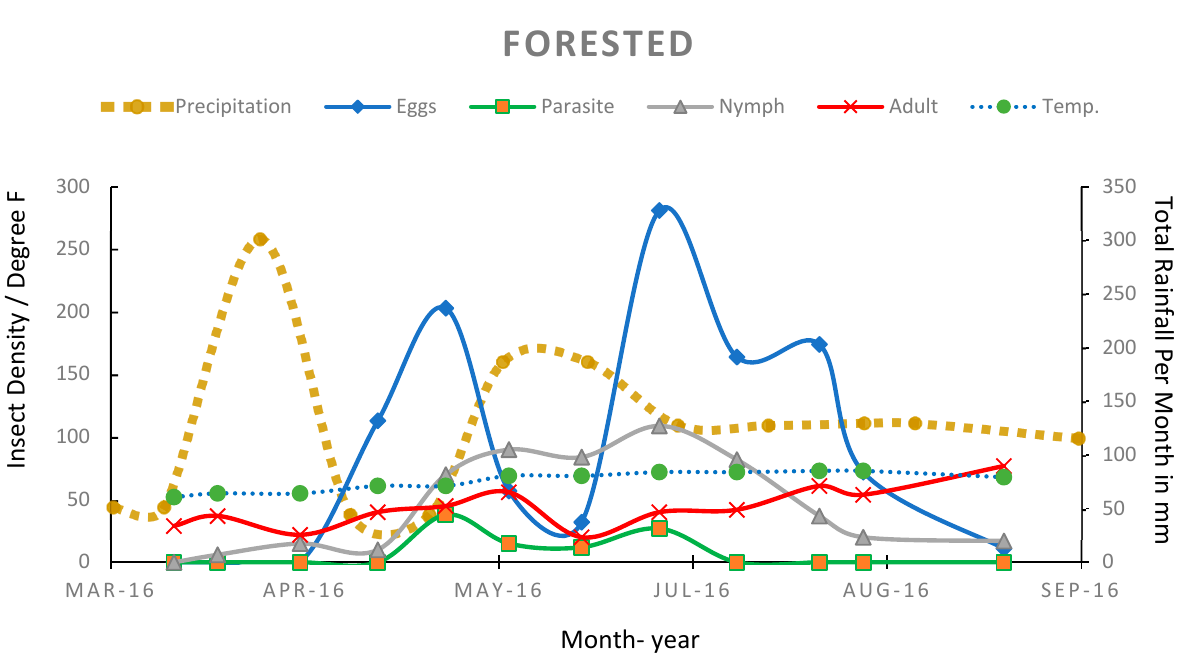
Figure 2. Population dynamics of M. cribraria and P. saccharalis for most active forested site in 2016. Host plant: kudzu.